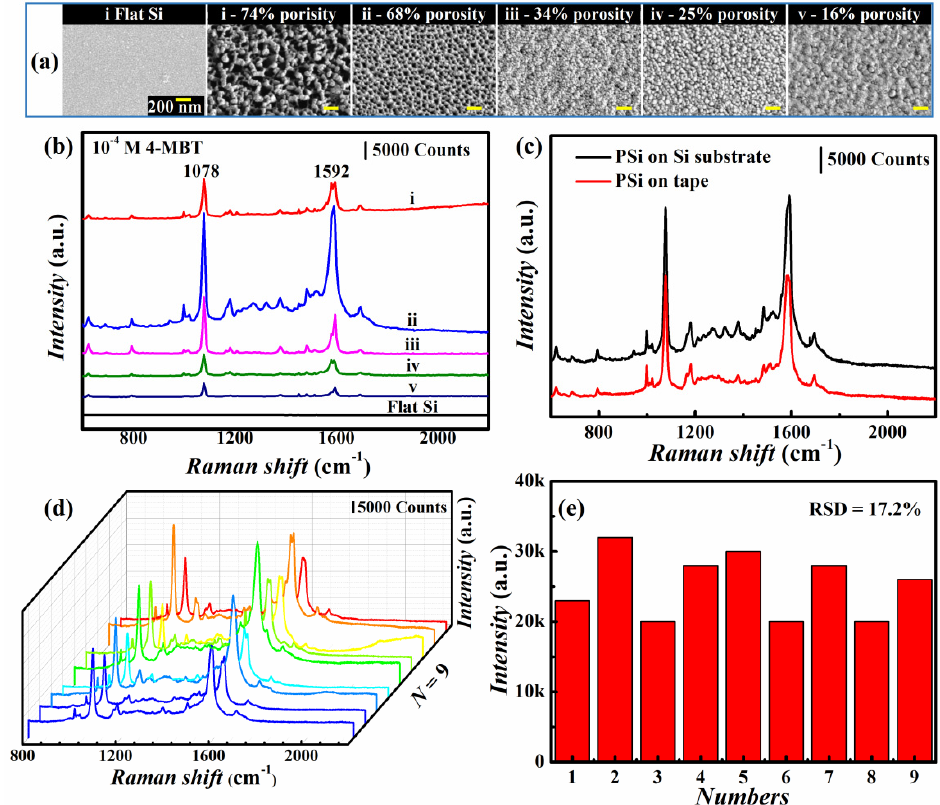
Figure 5. ( a ) SEM images of the samples for SERS characterization. ( b ) Raman spectra of 10 − 4 M 4-MBT collected on the samples of ( a ). ( c ) Raman spectra of 10 − 4 M 4-MBT collected on the optimized PSi films (sample ii) before and after transfer. ( d ) Raman spectra of 10 − 4 M 4-MBT from nine different PSi films substrates under optimized parameters corresponding to sample ii. ( e ) Raman